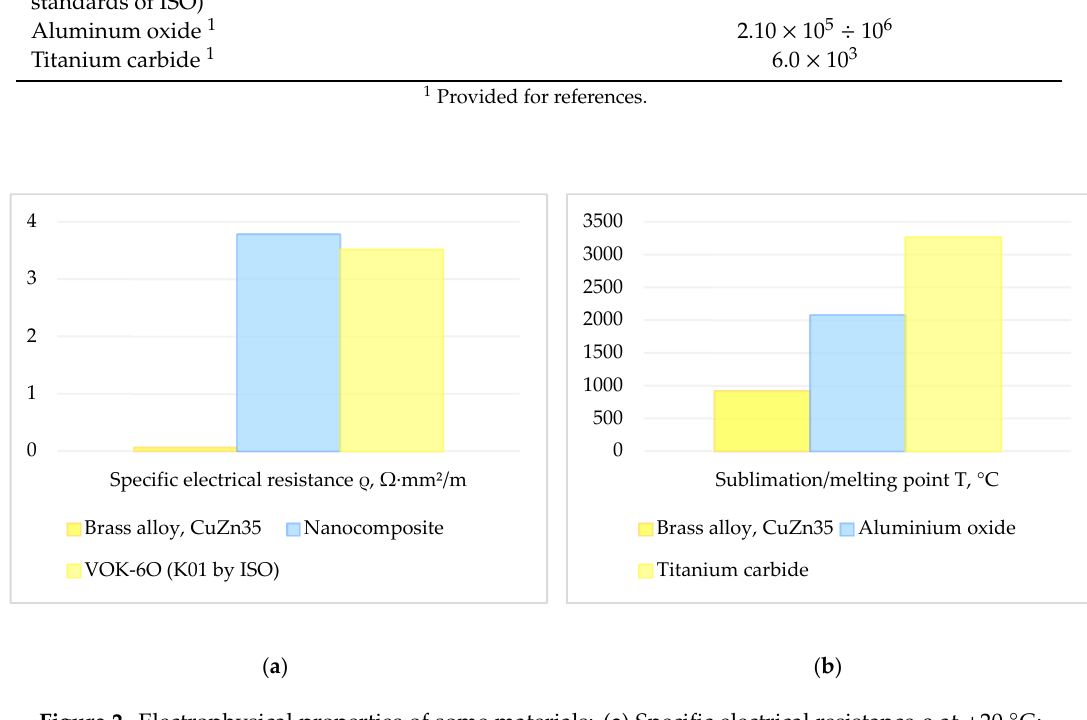
Figure 2. Electrophysical properties of some materials: ( a ) Specific electrical resistance ρ at +20 °C; ( b ) Sublimation / melting point T .